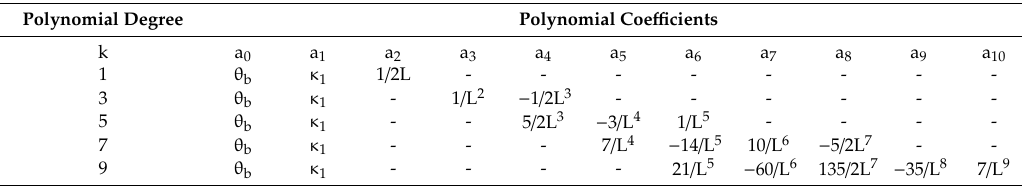
Table 2. The list of dependences for the polynomial coe ffi cients describing the angle of tangent to the curve θ